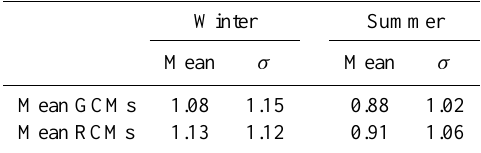
Table 3. Relative changes in mean precipitation and the standard deviation ( σ ) of the 5-day precipitation sums after the transforma- tion of the observations according to the changes in the GCM and RCM simulations. The changes are shown for the winter half-year (October–March) and the summer half-year (April–September). Winter Summer Mean σ Mean